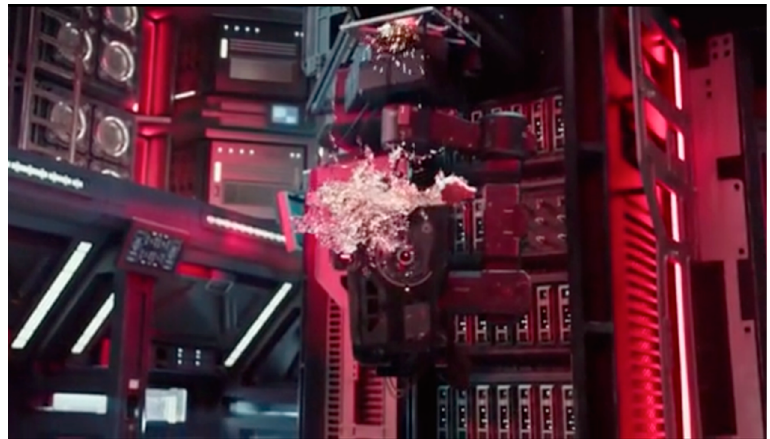
Figure 2. Liu Peiqiang sets MOSS on fire.